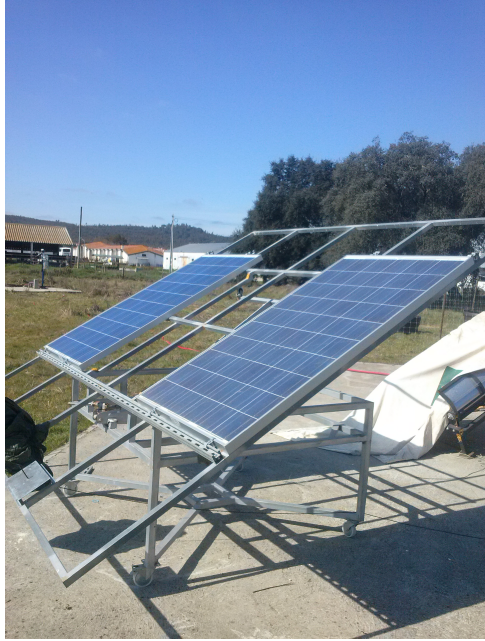
Figure 2. PV apparatus in